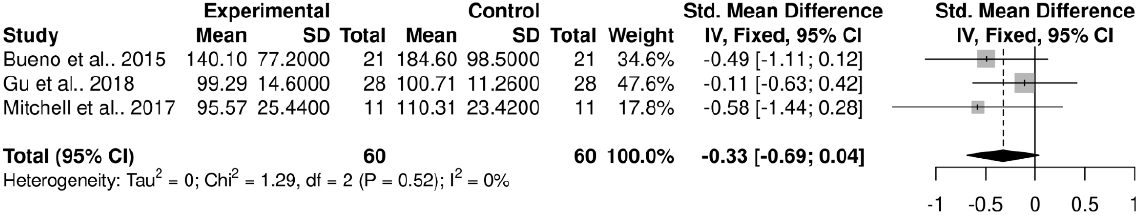
Figure 2. Random effects meta-analysis conflict measures in the Attentional Network Test (ANT), indicative of executive attention improvements after the mindfulness intervention. Experimental refers to after the mindfulness intervention, whilst control provides baseline data [86,88,91,92].